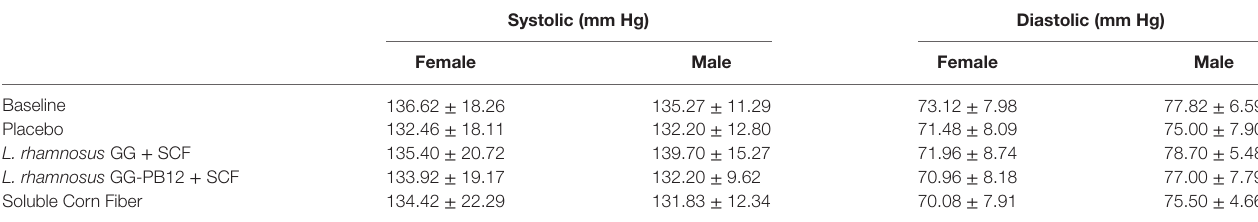
TaBlE 3 | Blood pressure in each group after the treatment ( n = 37).